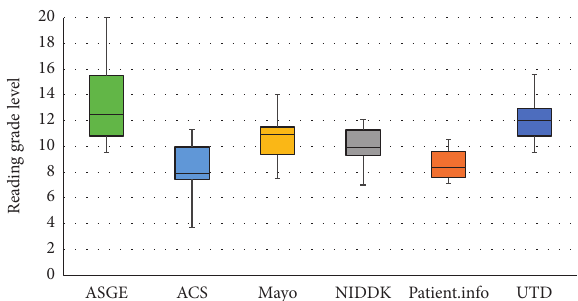
Figure 4: Box and whisker plot analysis of the reading material regarding flexible sigmoidoscopies. The American Society for Gastro- intestinal Endoscopy (ASGE) had a median of 12.5 (9.5–20), the American Cancer Society (ACS) had a median of 7.9 (3.7–11.3), Mayo Clinic had a median of 11.0 (7.5–14.0), the National Institute of Diabetes and Digestive and Kidney Diseases (NIDDK) scored a median of 9.9 (7.0–12.1), Patient.info had a median of 8.4 (7.1–10.5), and UpToDate Beyond the Basics (UTD) had scored median of 12.0